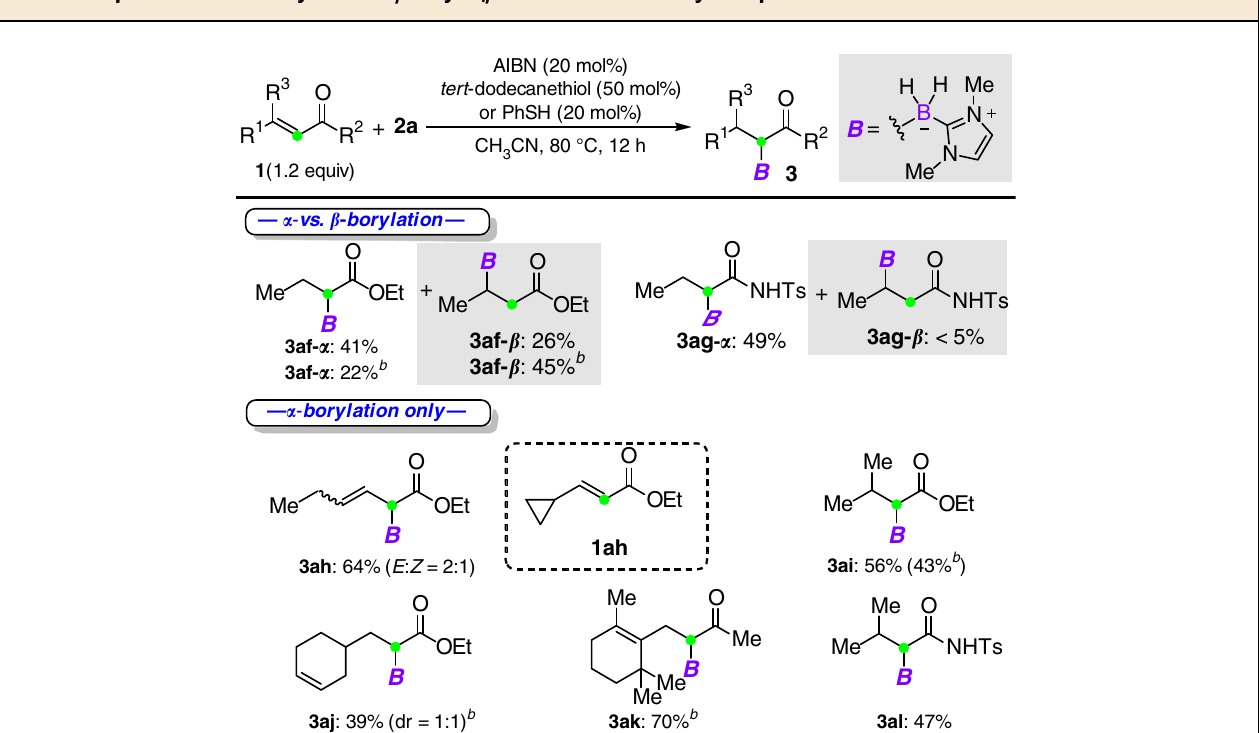
Table 3 Scope of radical α -borylation of β -alkyl- α , β -unsaturated carbonyl